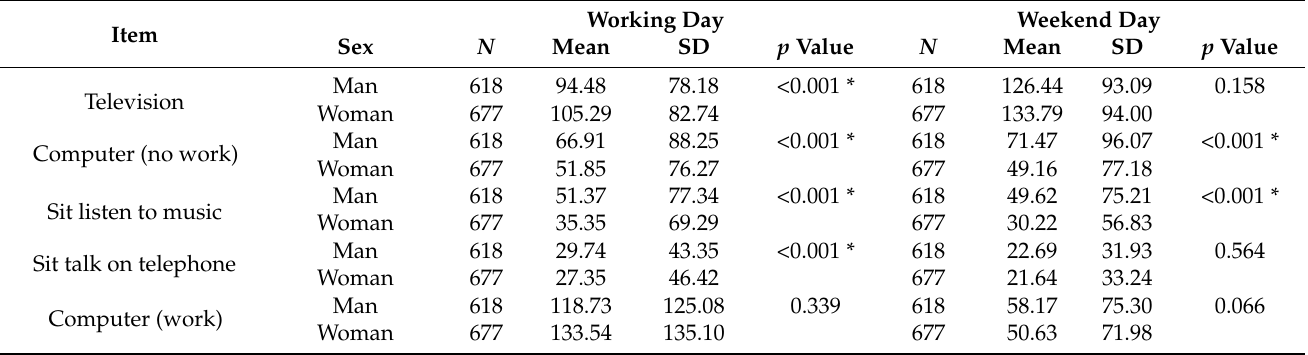
Table 5. Difference between sexes with respect to time spent sitting per sedentary